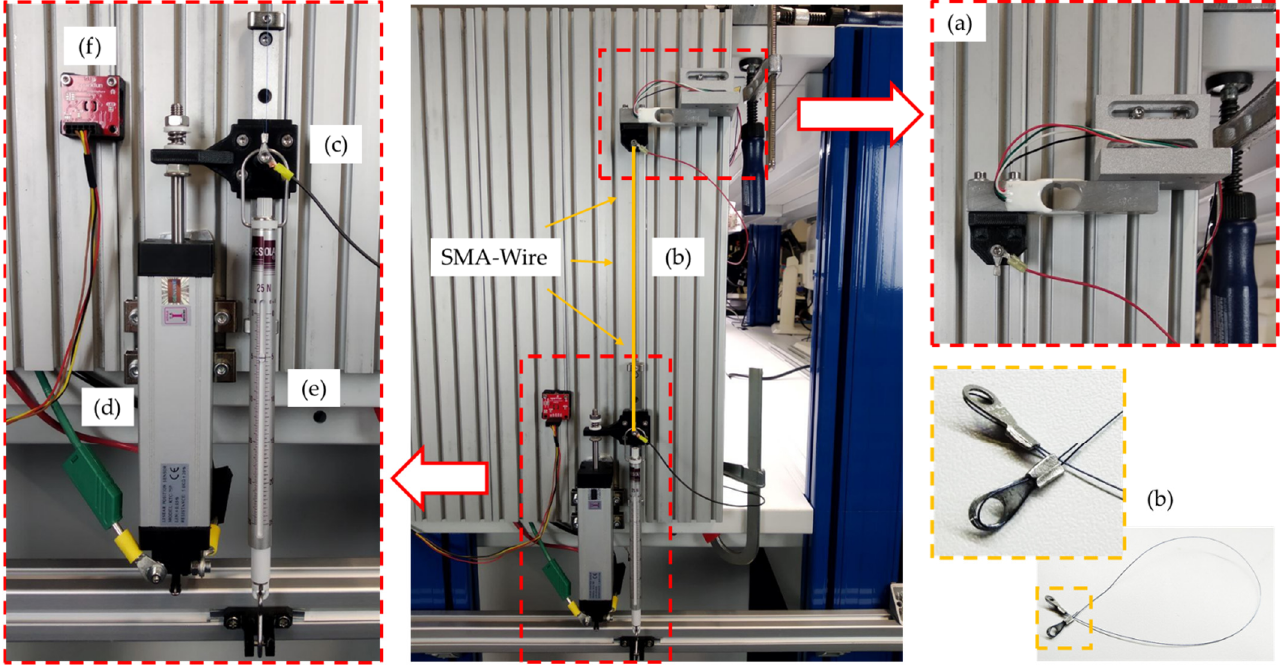
Figure 6. Vertical test rig for pre-tests: ( a ) load cell Sauter CK 6-0P1 (KERN & SOHN GmbH, Balingen-Frommern, DE); ( b ) 250 × 0.25 mm SMA wire actuator; ( c ) connecting platform; ( d ) linear potentiometer KTC 75 P (Ixthus Instrumentation, Towcester, UK); ( e ) tension spring balance Medio 25 N (PESOLA Präzisionswaagen AG, Schindellegi, CH) to generate the necessary counterforce; and ( f ) temperature sensor TMP117 (SparkFun Electronics, Boulder, CO, USA).